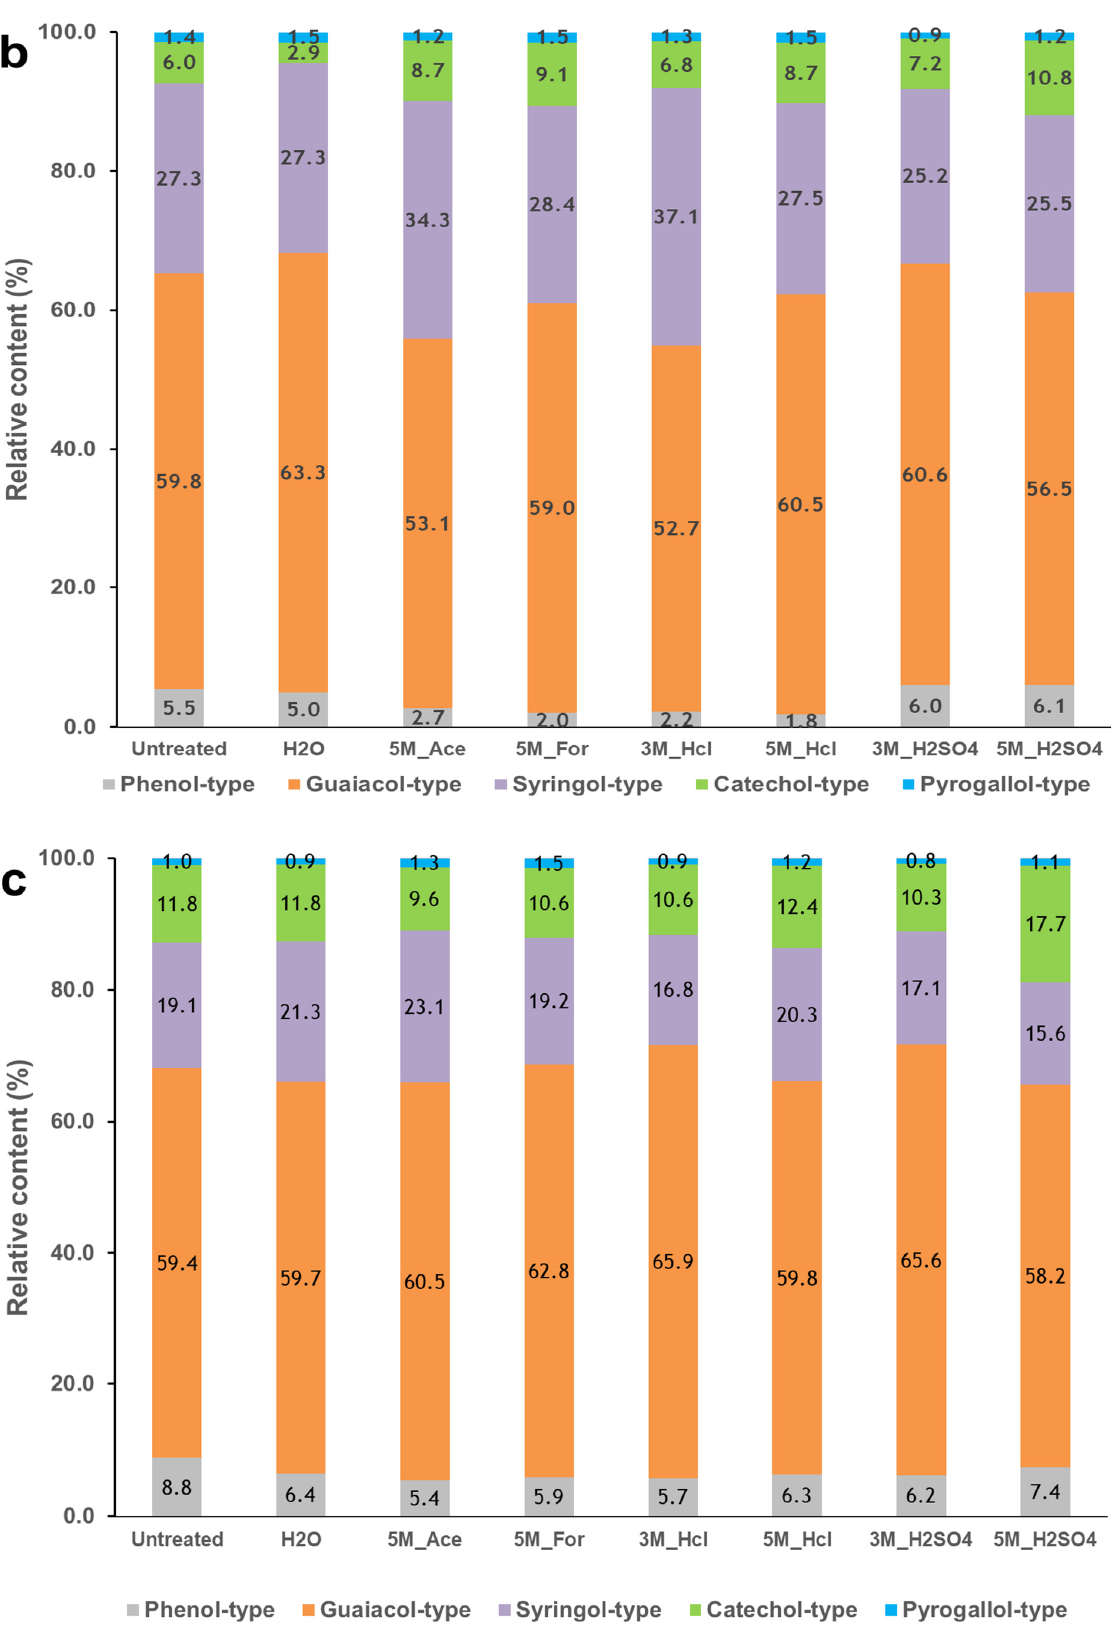
Figure 8. Effect of water and acid leaching on the lignin-derived products of PKS ( a ), MAH ( b ) and IRO ( c ).